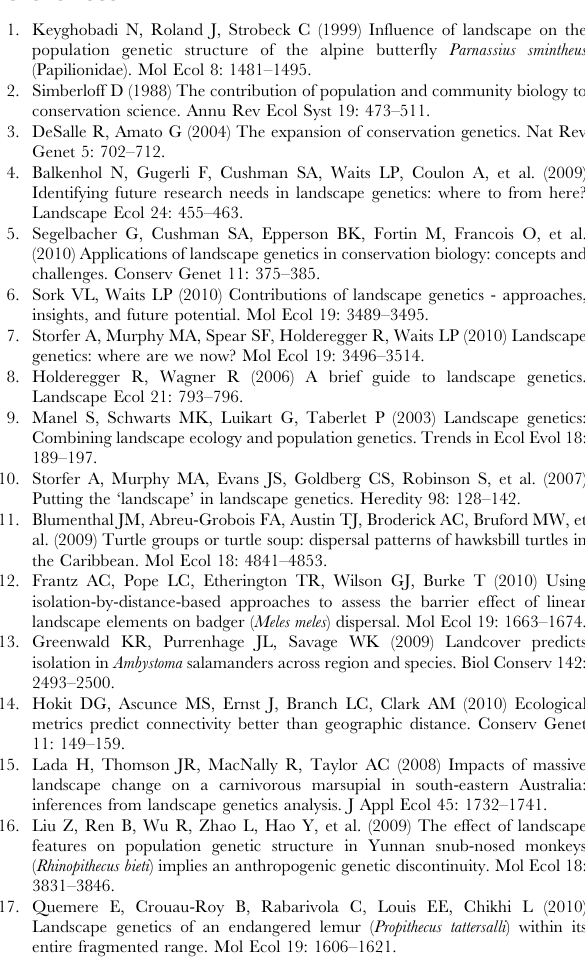
Figure S1 Inference of the number of genetic clusters (K) estimated using STRUCTURE. (DOC) Figure S2 Ranked mean Q (proportional membership in each cluster) for each individual. (DOC) Table S1 Microsatellite markers amplified in 244 Saimiri oerstedii samples. Table S2 Results of simple and partial Mantel tests between genetic distances (Moran’s I and Rousset’s aˆ ) and cost distances among all individuals. Table S3 Results of simple and partial Mantel tests between genetic distances (Moran’s I and Rousset’s aˆ ) and cost distances, including only sample pairs within the eastern population. Table S4 Results of simple and partial Mantel tests between genetic distances (Moran’s I and Rousset’s aˆ ) and cost distances, including only sample pairs within the western